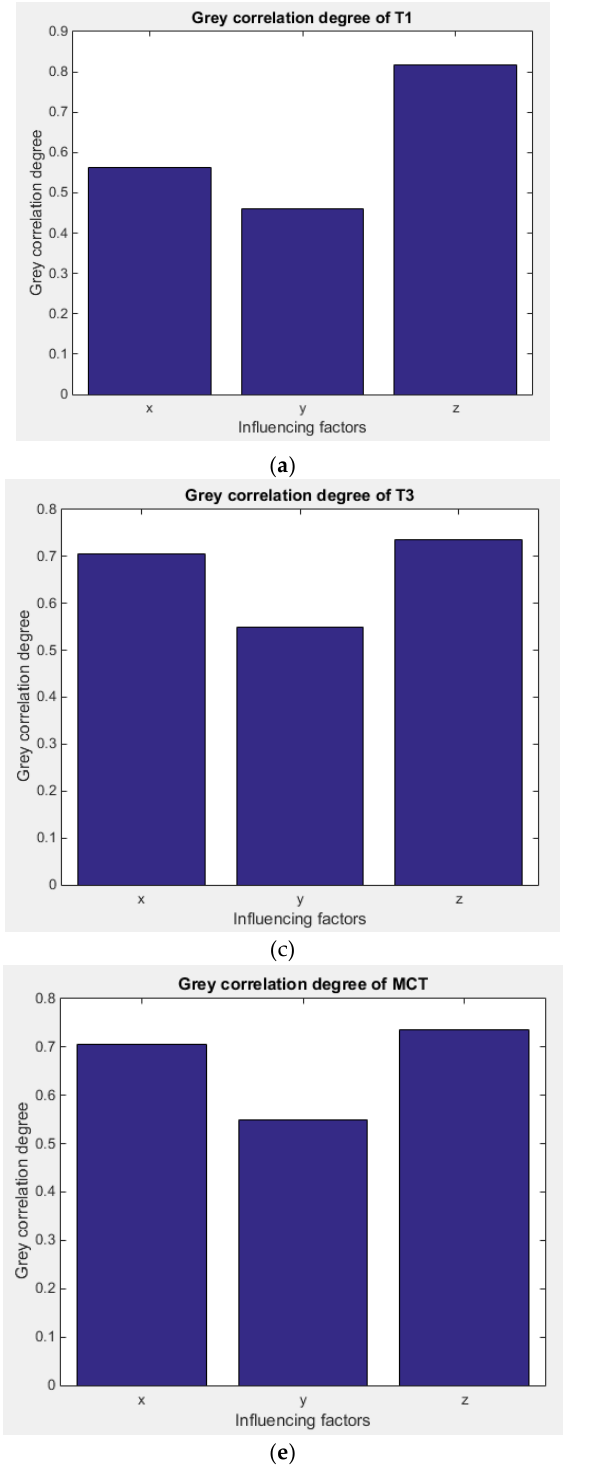
Figure 7. CTSAIs for camera robots: ( a ) grey correlation degree of T 1 , ( b ) grey correlation degree of T 2 ; ( c ) grey correlation degree of T 3 , ( d ) grey correlation degree of T 4 , ( e ) grey correlation degree of MCT, ( f ) grey correlation degree of MCT ( 0.6 = ).